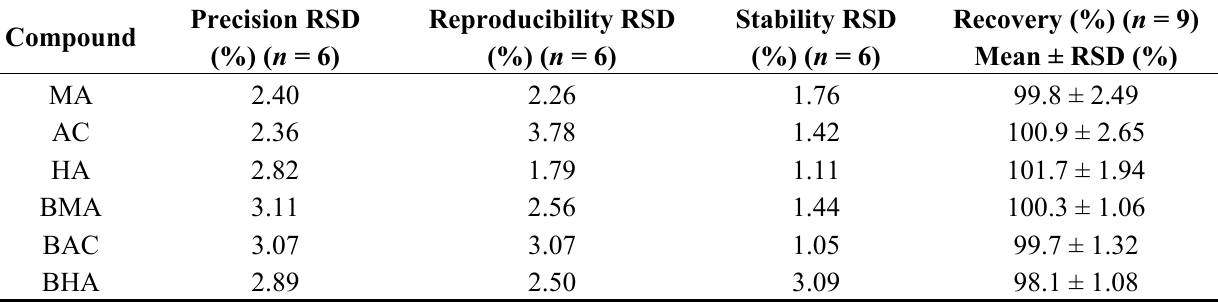
Table 4. Precision, reproducibility, stability, and recovery of the six